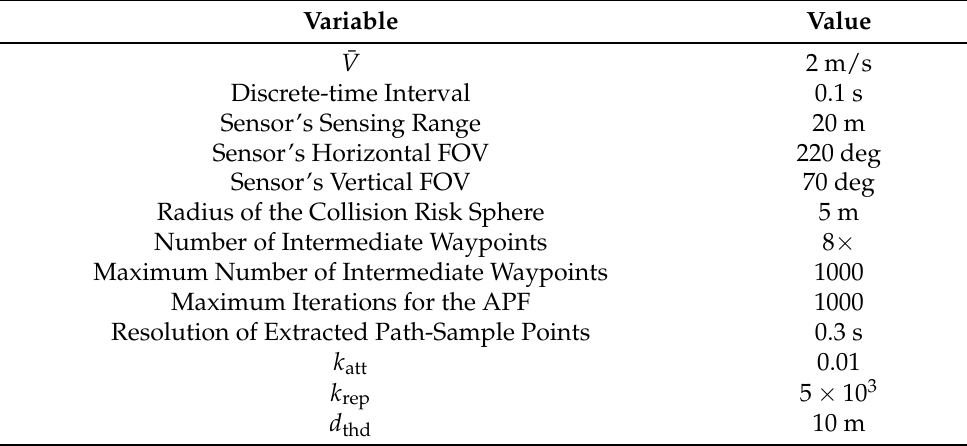
Table 2. Simulation parameters.